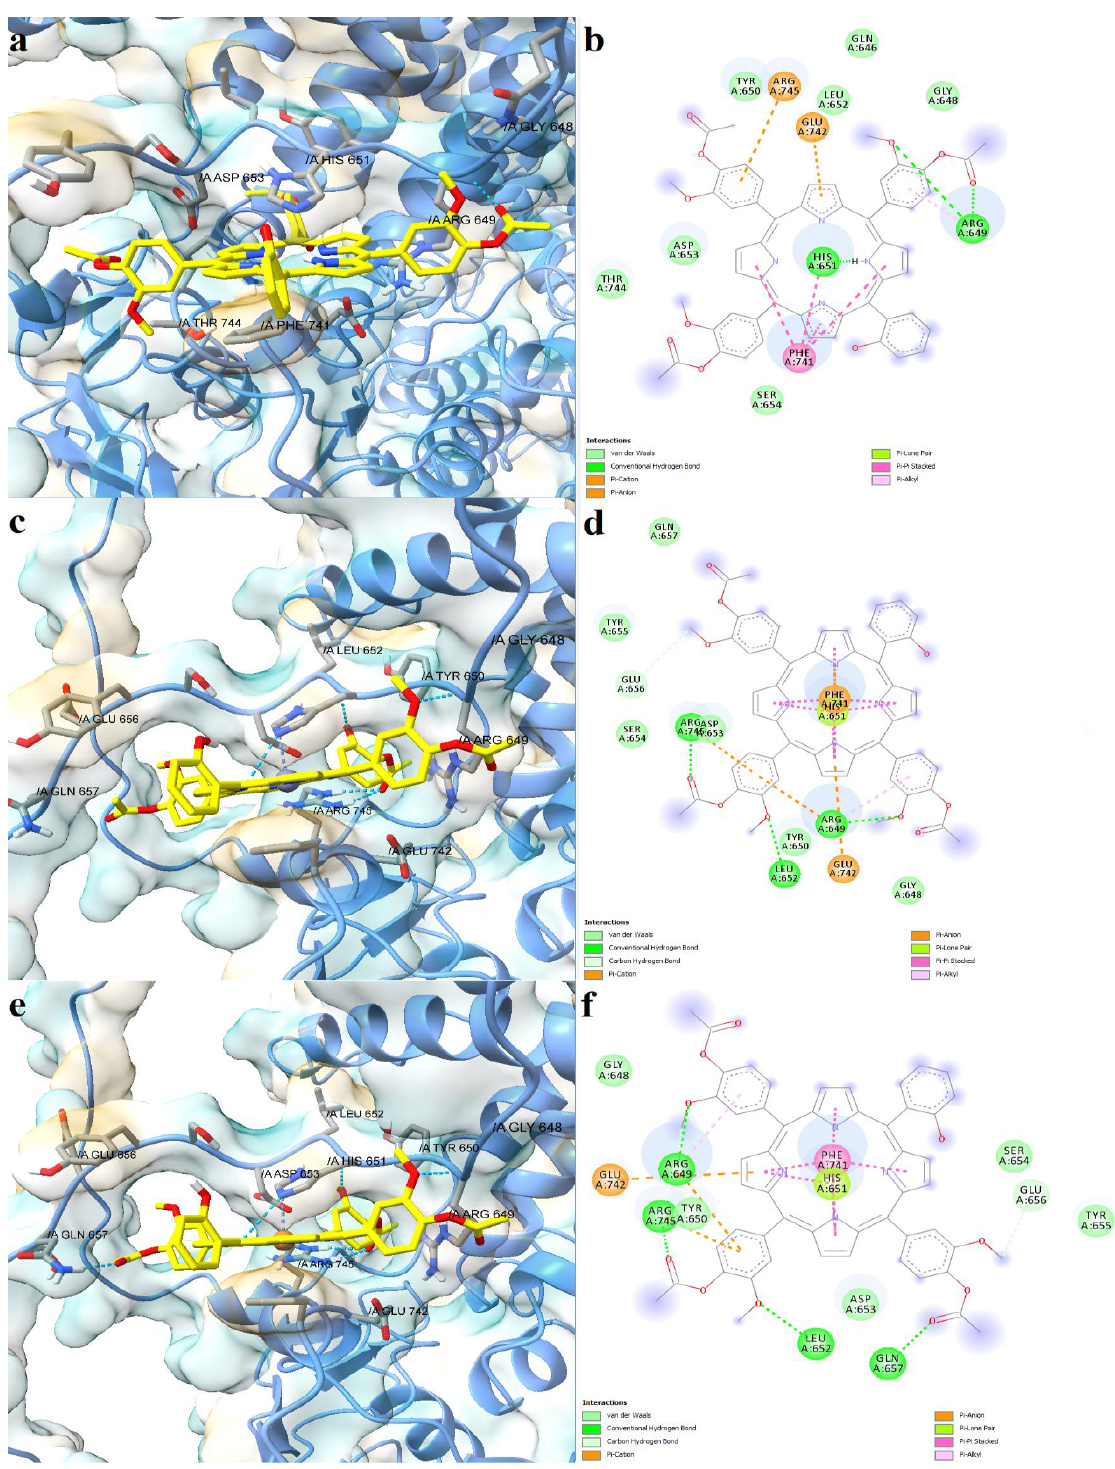
Figure 9. Predicted binding modes between porphyrin derivatives and the SUR2 subunit of K ATP . ( a ) — predicted conformation of TMAPOHo-SUR2 complex; ( b ) — interaction diagram for TMAPOHo-SUR2 complex; ( c ) — predicted conformation of Zn(II)TMAPOHo-SUR2 complex; ( d ) — interaction diagram for Zn(II)TMAPOHo-SUR2 complex; ( e ) — predicted conformation of Cu(II)TMAPOHo-SUR2 complex; ( f ) — interaction diagram for Cu(II)TMAPOHo-SUR2 complex. Metal coordination bonds are represented as purple dashes.